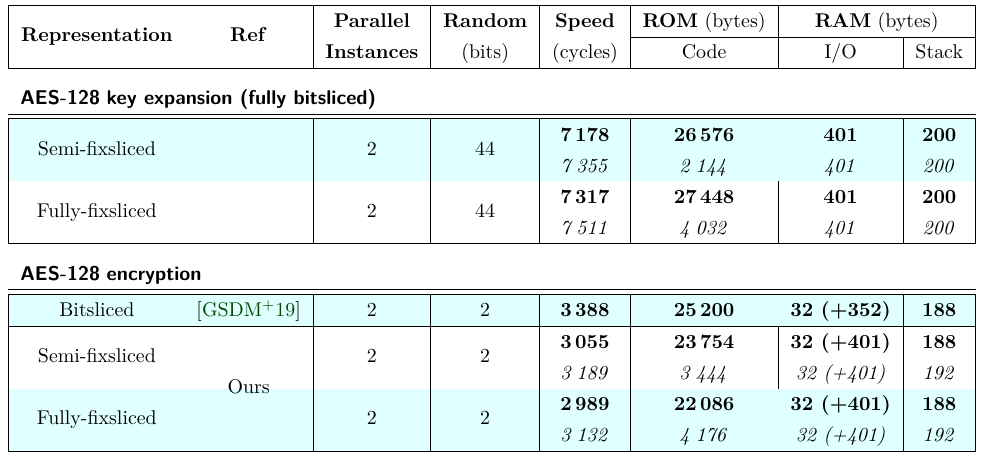
Table 4: First-order masked implementation results on ARM-Cortex M4 for various bitsliced representations of AES-128 . For encryption routines, speed is expressed in cycles per block and the RAM requirements for the round keys are enclosed in